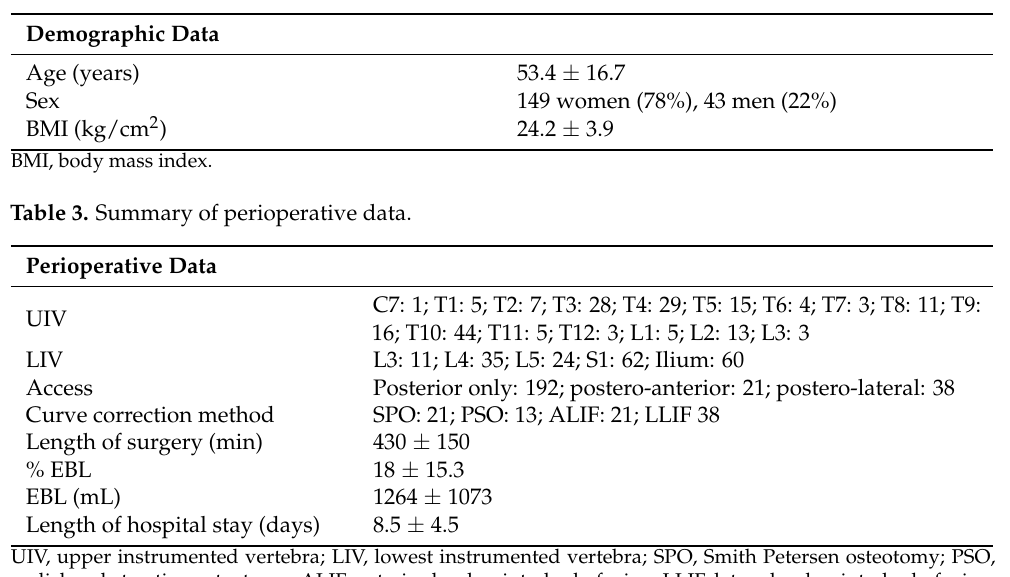
Table 2. Overview of the patients’ demographics.